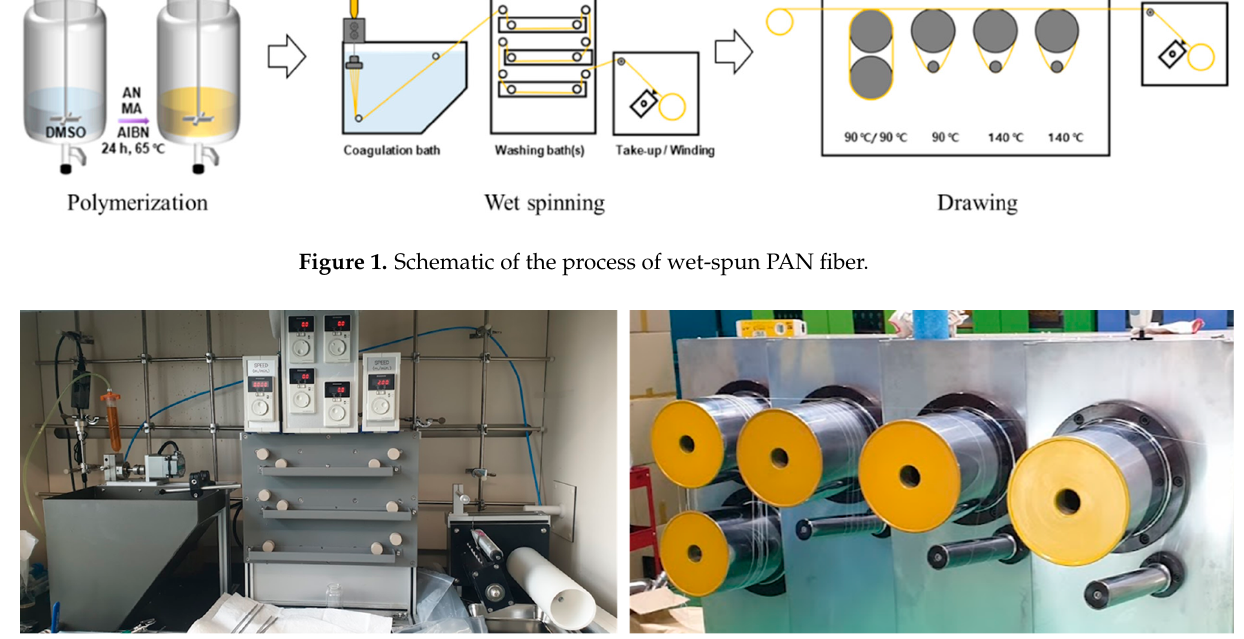
Figure 2. Lab-scale wet-spinning and drawing equipment.